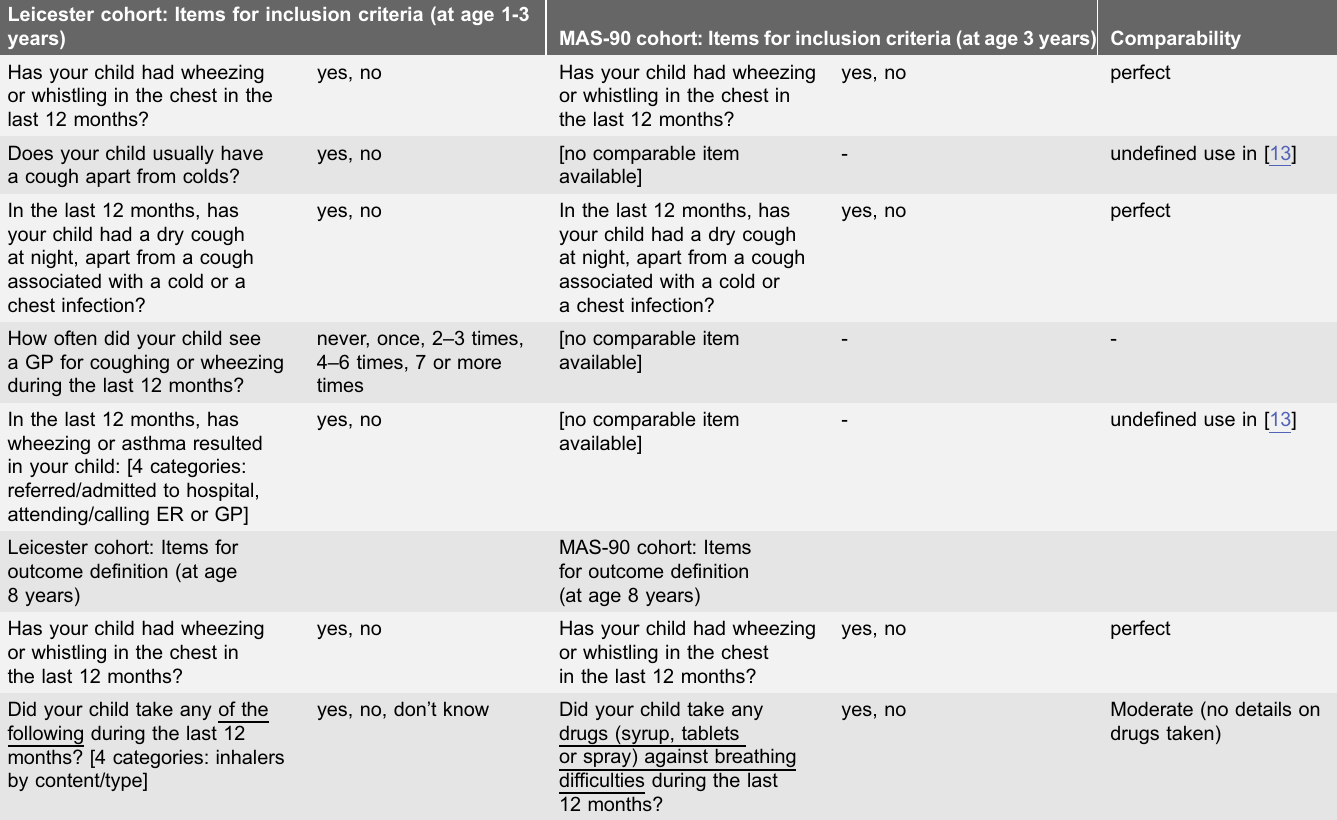
Table 4. Questionnaire items used as inclusion criteria and outcome definition, comparing original and validation cohort. Leicester cohort: Items for inclusion criteria (at age 1-3